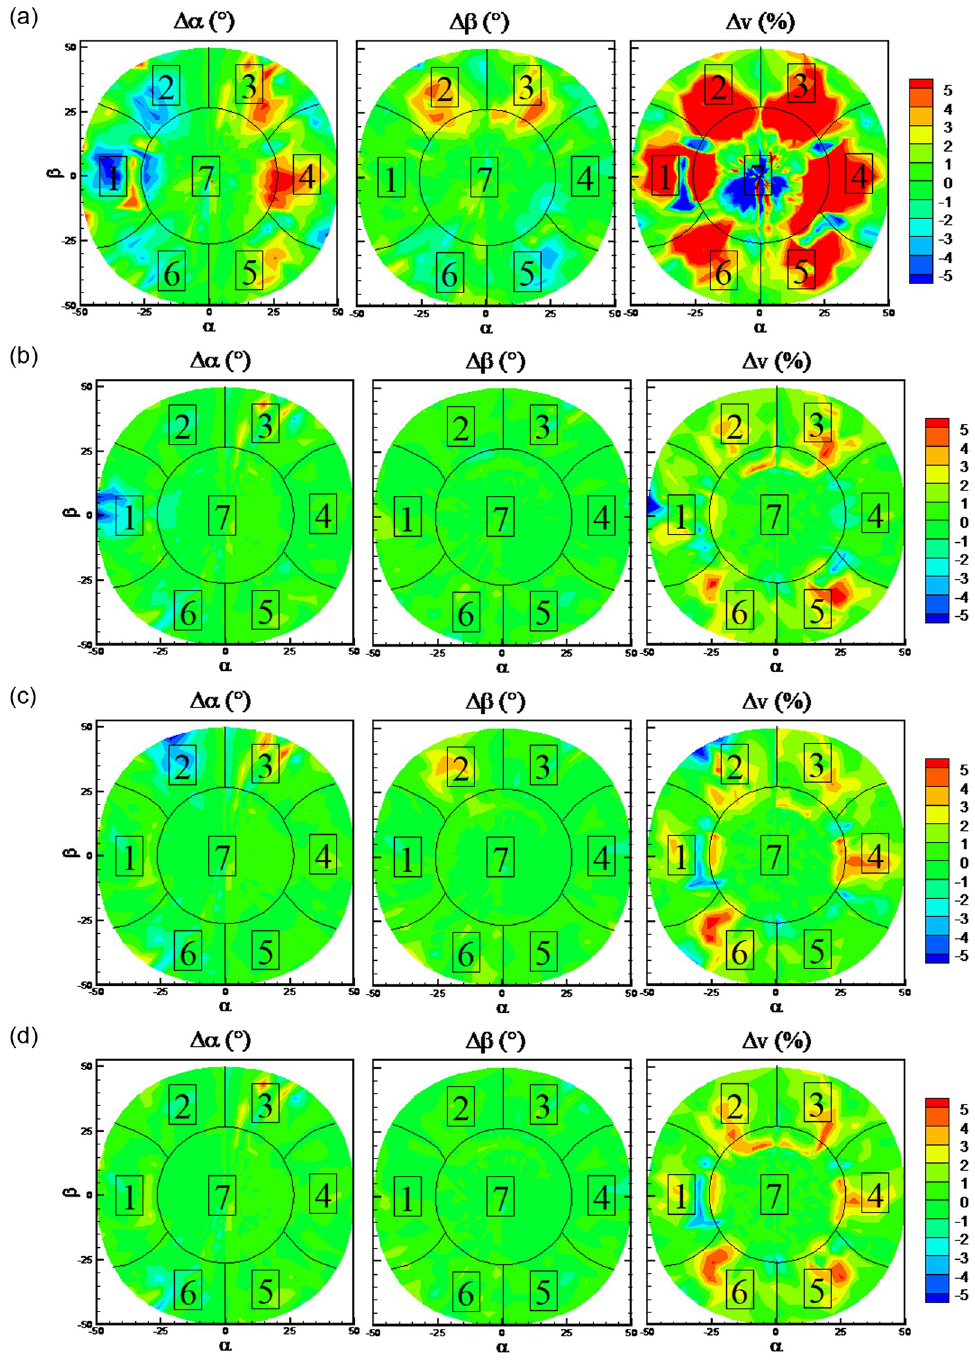
Fig 29. Error distributions with KNN algorithm. a) port 7 is invalid, b) port 1 is invalid, c) port 2 is invalid, d) normal case: all ports are valid.